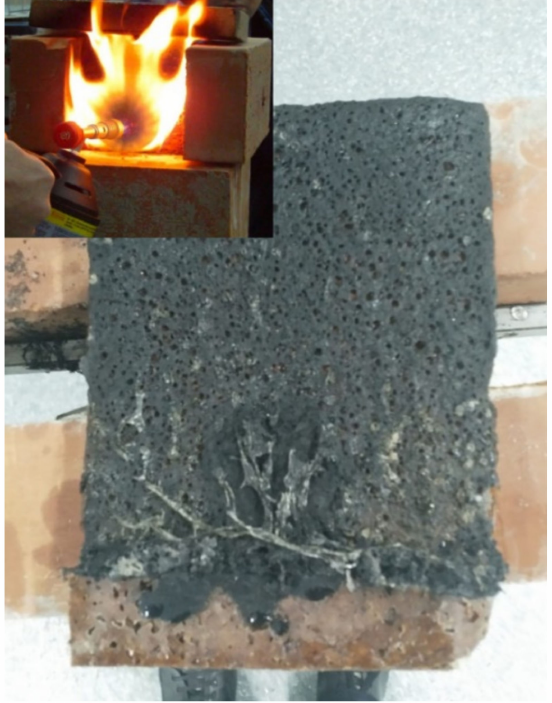
Figure 3. “Liquid wood” fire testing and “peeling effect” of burnt layers